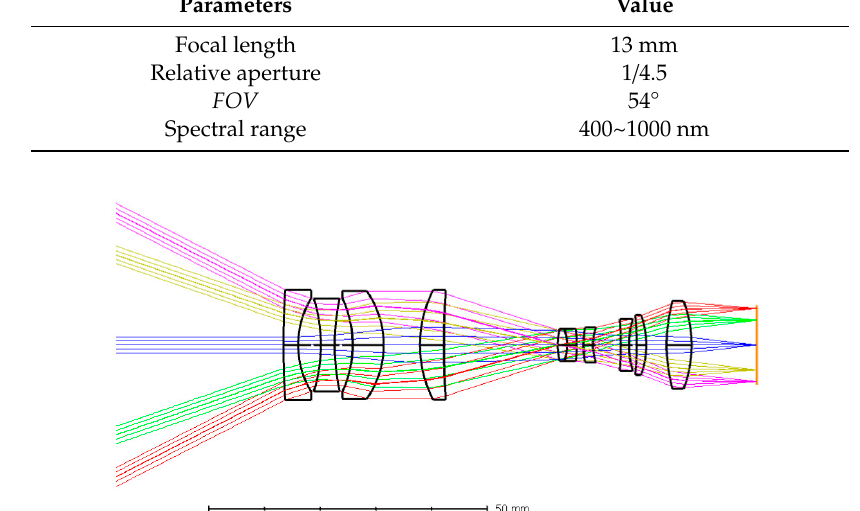
Figure 5. The layout of the objective lens. Appl. Sci. 2020 , 10 , x FOR PEER REVIEW